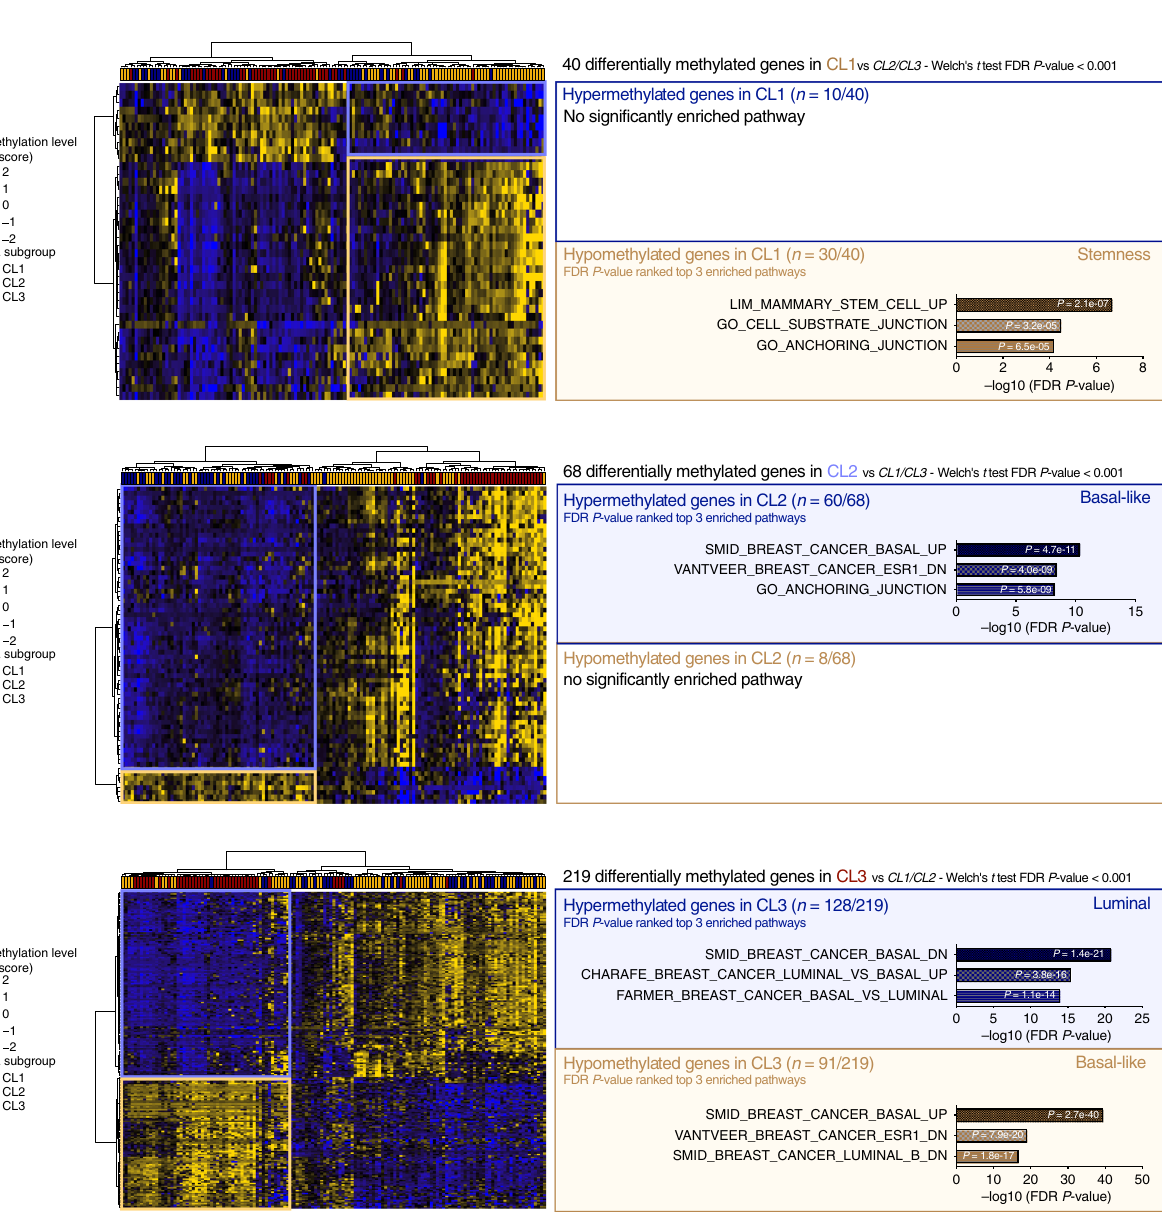
Fig. 4 Claudin-low subgroups show distinct gene methylation pro fi les relative to their differentiation status. Heatmaps and pathway-enrichment analysis of differentially methylated genes between a CL1 vs. CL2 and CL3 tumors from TCGA, b CL2 vs. CL1 and CL3 tumors from TCGA, and c CL3 vs. CL1 and CL2 tumors from TCGA. CL1 tumors mainly display hypomethylated genes that are related to a stemness phenotype, CL2 tumors are overall hypermethylated for genes associated with basal-like features, and CL3 tumors show more heterogeneous methylation pro fi les with both hypermethylated genes (linked to luminal phenotype) and hypomethylated genes (relative to basal-like characteristics) (see Supplementary Fig. 5 for methodology). Clustering method: Ward ’ s; distance: Spearman. FDR: false discovery